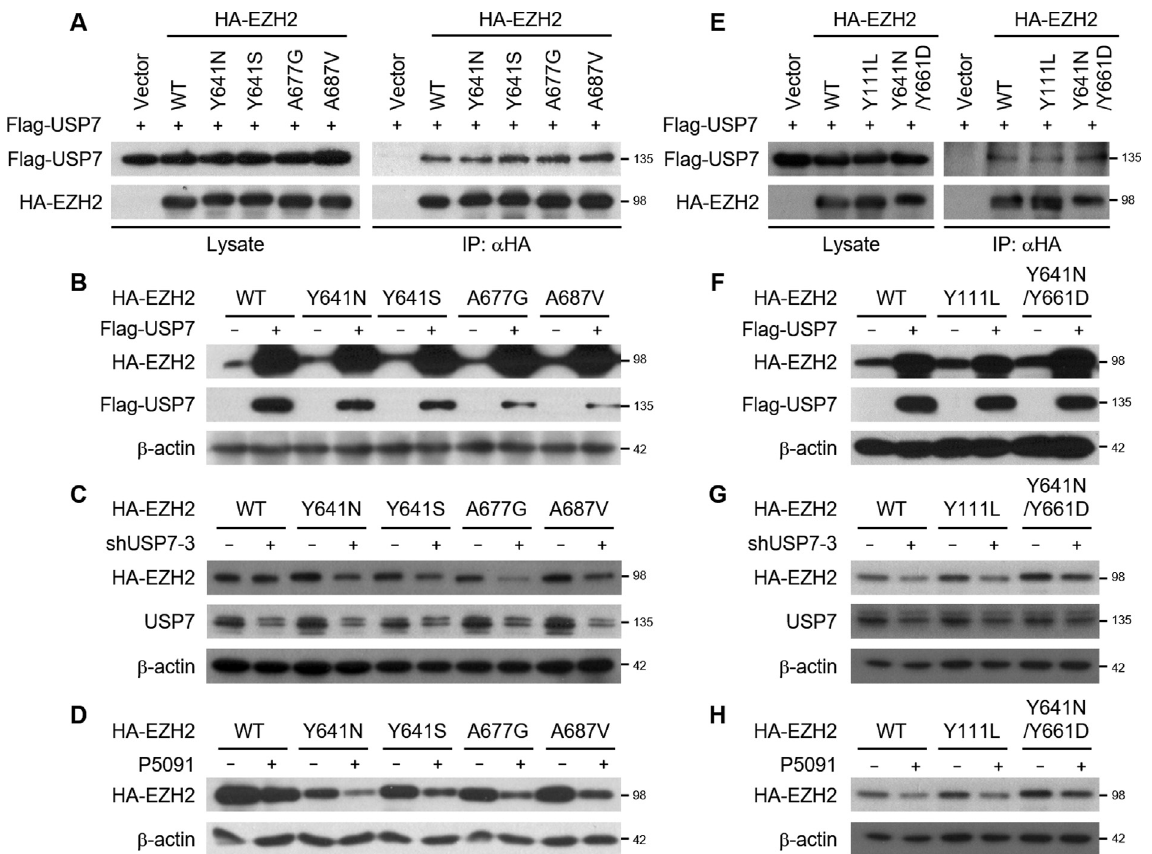
Figure 3 - USP7 stabilizes oncogenic EZH2 mutants. (A) Flag-USP7 was expressed in HEK293T cells with HA-tagged gain-of-function EZH2 mutants. Cell lysates were subjected to immunoprecipitation with HA antibody and immunoblotted with anti-Flag or anti-HA antibody. (B) HEK293T cells were transfected with Flag-USP7 and HA-tagged gain-of-function EZH2 mutants. Cell lysates were immunoblotted with anti-Flag or anti-HA antibody. (C) HEK293T cells were transfected with USP7 shRNA and HA-tagged gain-of-function EZH2 mutants. Cell lysates were immunoblotted with anti-HA or anti-USP7 antibody. (D) HA-tagged gain-of-function EZH2 mutants were expressed in HEK293T cells, which were then treated with P5091 (12.5 (cid:2) M) for 24 h before harvesting. Cell lysates were immunoblotted with anti-HA antibody. (E) Flag-USP7 was expressed in HEK293T cells with HA-tagged therapy-resistant EZH2 mutants. Cell lysates were subjected to immunoprecipitation with HA antibody and immunoblotted with anti-Flag or anti-HA an- tibody. (F) HEK293T cells were transfected with Flag-USP7 and HA-tagged therapy-resistant EZH2 mutants. Cell lysates were subjected to immuno- blotting with anti-HA or anti-Flag antibody. (G) HEK293T cells were transfected with USP7 shRNA and HA-tagged therapy-resistant EZH2 mutants. Celllysateswereimmunoblottedwithanti-HAoranti-USP7antibody.(H)HEK293TcellsweretransfectedwithHA-taggedtherapy-resistantEZH2mu- tants and treated with P5091 (12.5 (cid:2) M) for 24 h before harvesting. Cell lysates were immunoblotted with anti-HA